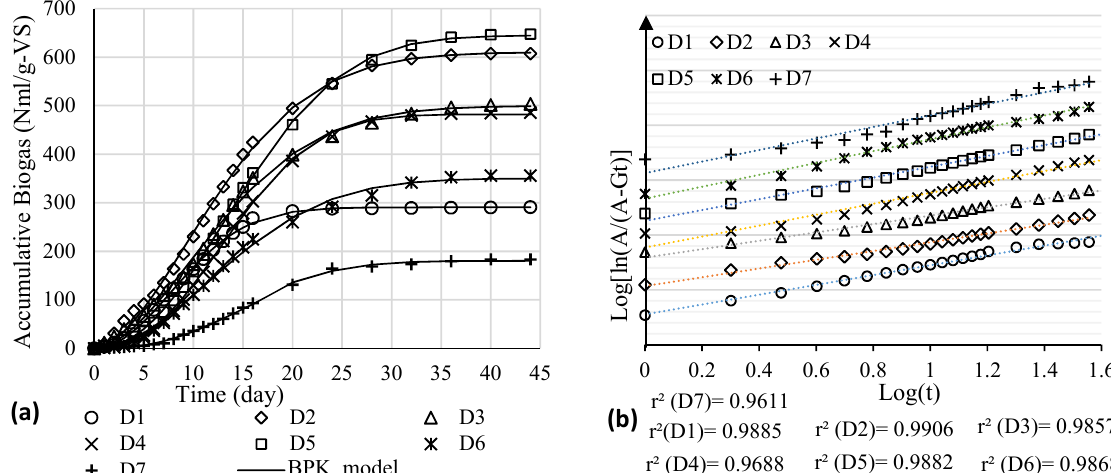
BPK Fig. 5: a) Accumulative gas production from experiments and BPK model; b) Relationship between log(ln(A/(A-G